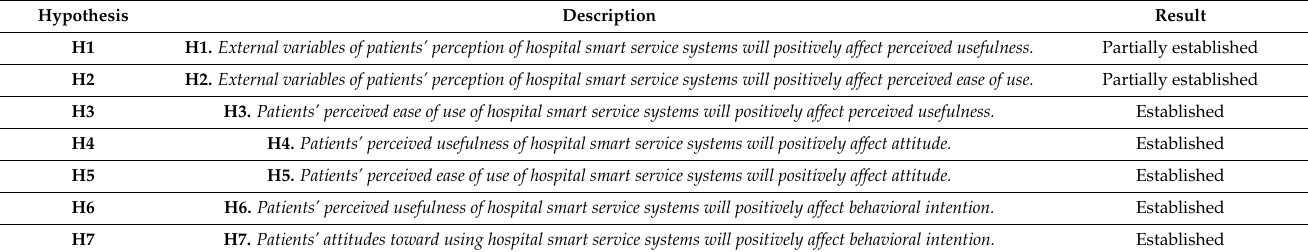
Figure 6. Research hypotheses results. Table 14. Analysis of the research hypothesis